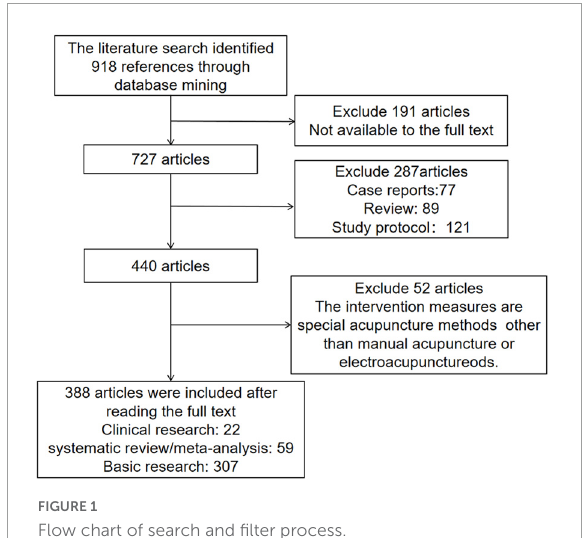
FIGURE1 Flow chart of search and filter